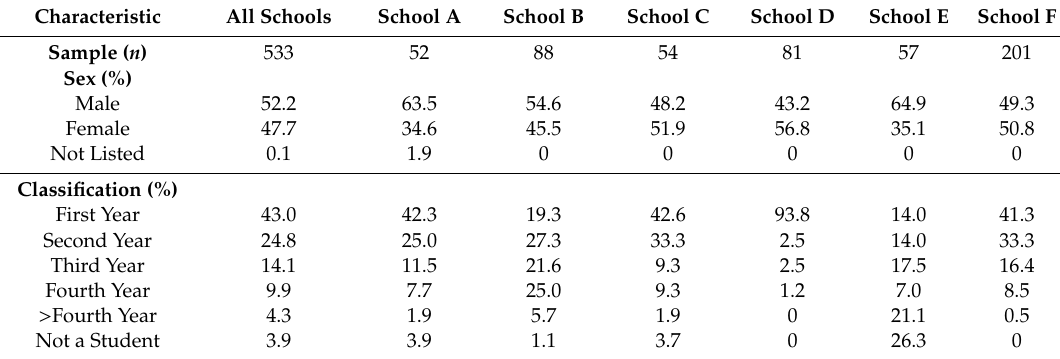
Table 2. Characteristics of students participating in the faith in fat study.